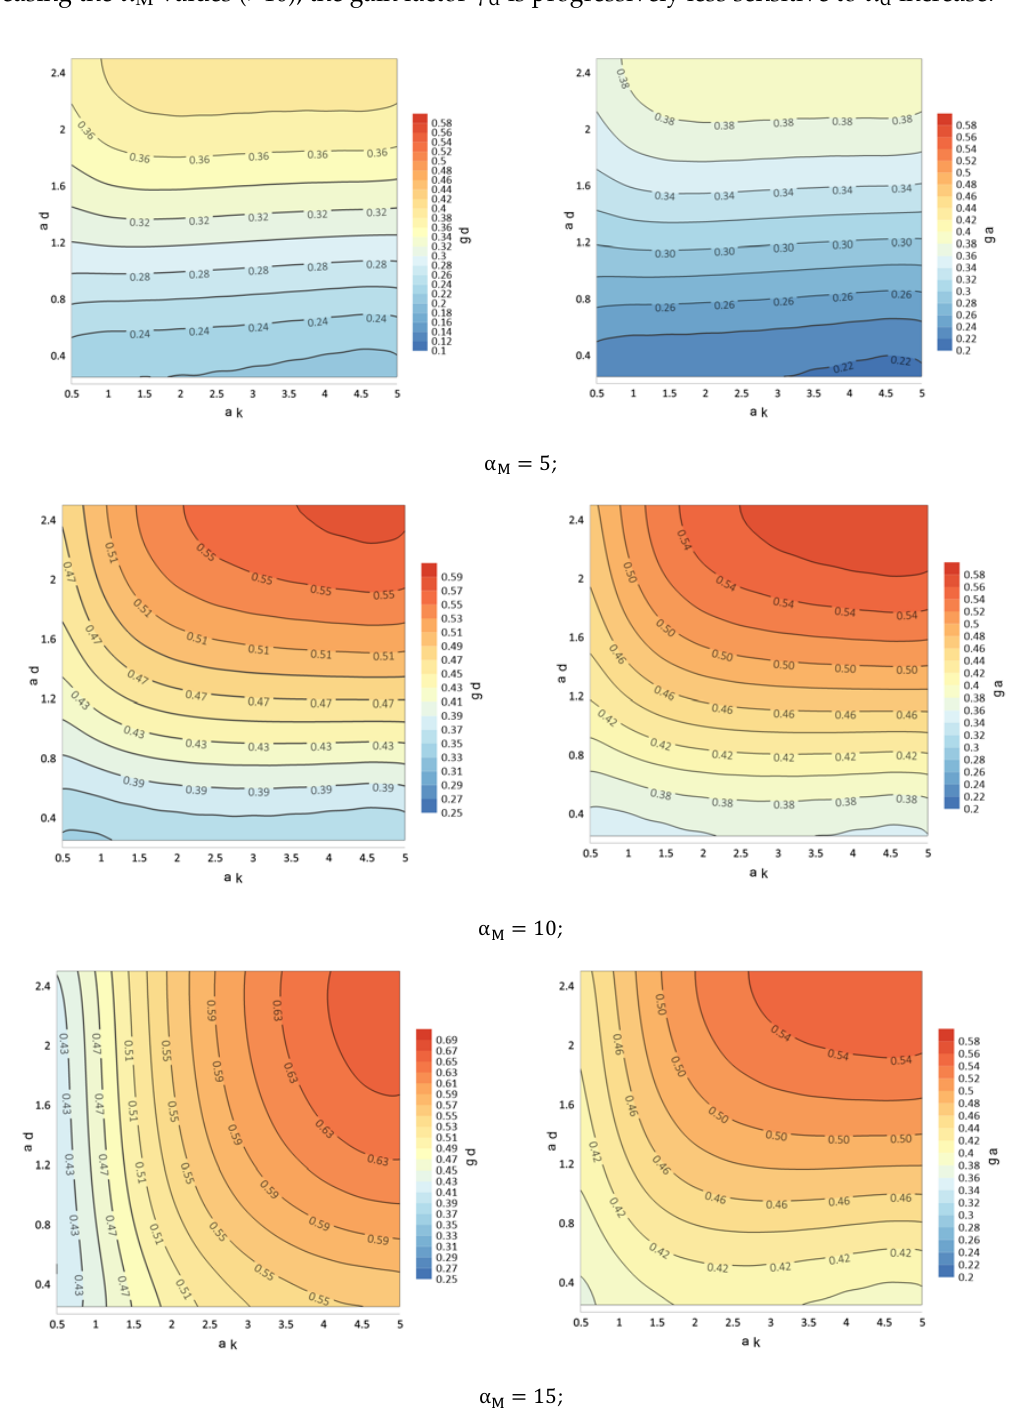
Figure 6. Gain maps in terms of γ d ( left ) and γ a ( right ) for various α (cid:2897) values.